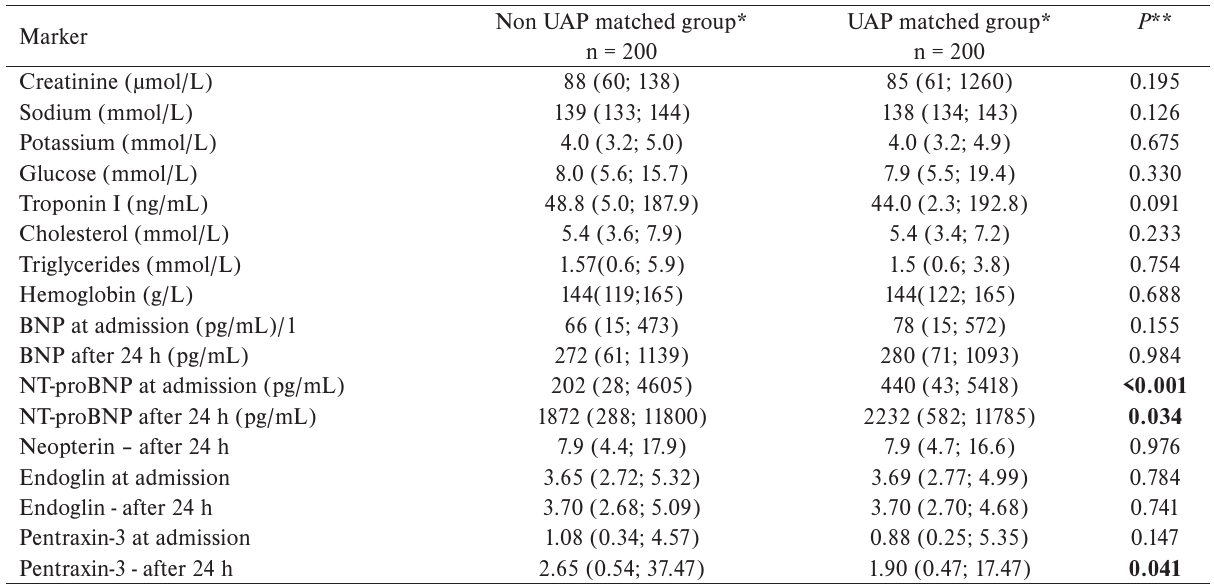
Table 2. Laboratory results and prognostic biomarkers according to the prodromal unstable angina pectoris in matched groups using propensity score.